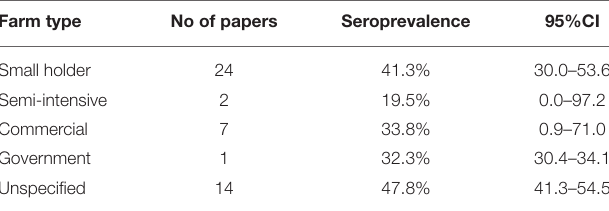
TABLE 3 | Summary table of weighted mean seroprevalence of antibodies to BVDV in low-and middle income countries stratified by farming system. Farm